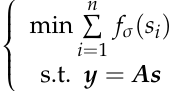
Figure 7. Diagram of −𝜎/(𝑠 (cid:3036)(cid:2870) + 𝜎) with different σ values.